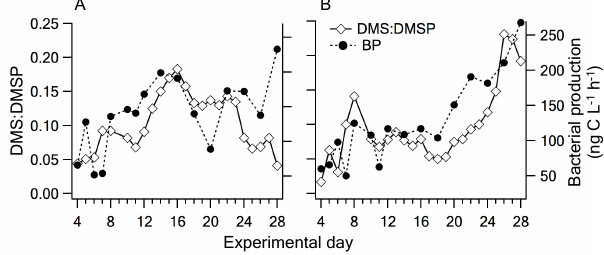
Fig. 8. Temporal trends in the molar ratio of DMS:DMSPt and bac- terial production (BP) measured in mesocosm 3 (close to ambient [H + ]) and mesocosm 9 (highest [H +